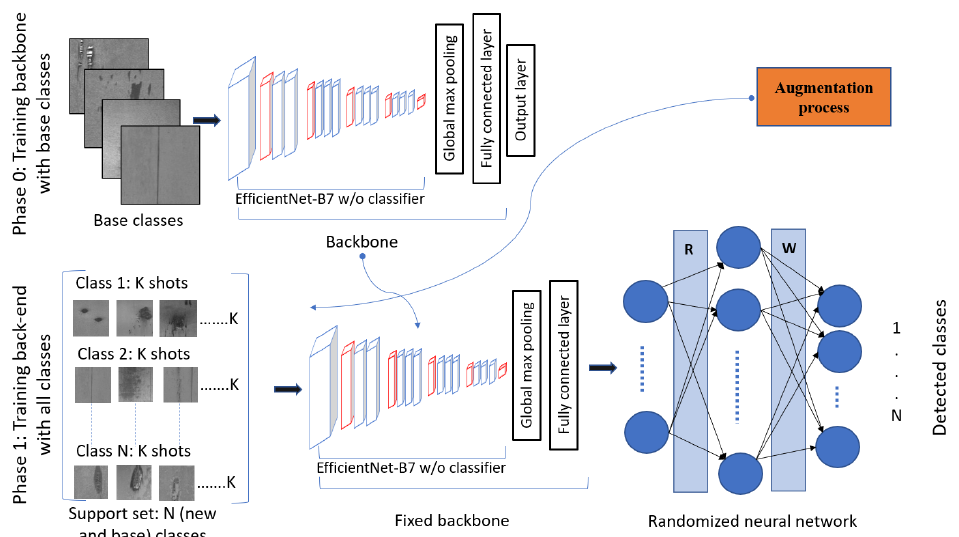
Figure 3. The proposed architecture (EffNet+RC) for few-shot learning. In phase 0, we train the backbone through a large number of samples of base classes. In phase 1 (and further phases), we use features extracted by the previously trained backbone. Here, only the weights W are computed with the help of a few samples, while weights R are random and